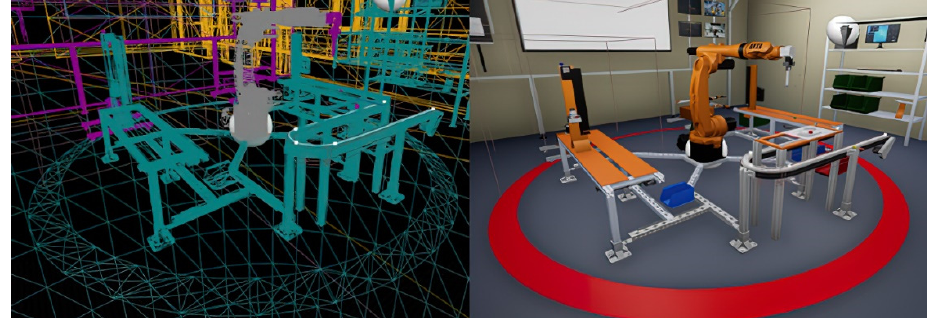
Figure 5. KUKA KR5 work area in LIT and wire views in Unreal Engine 4.